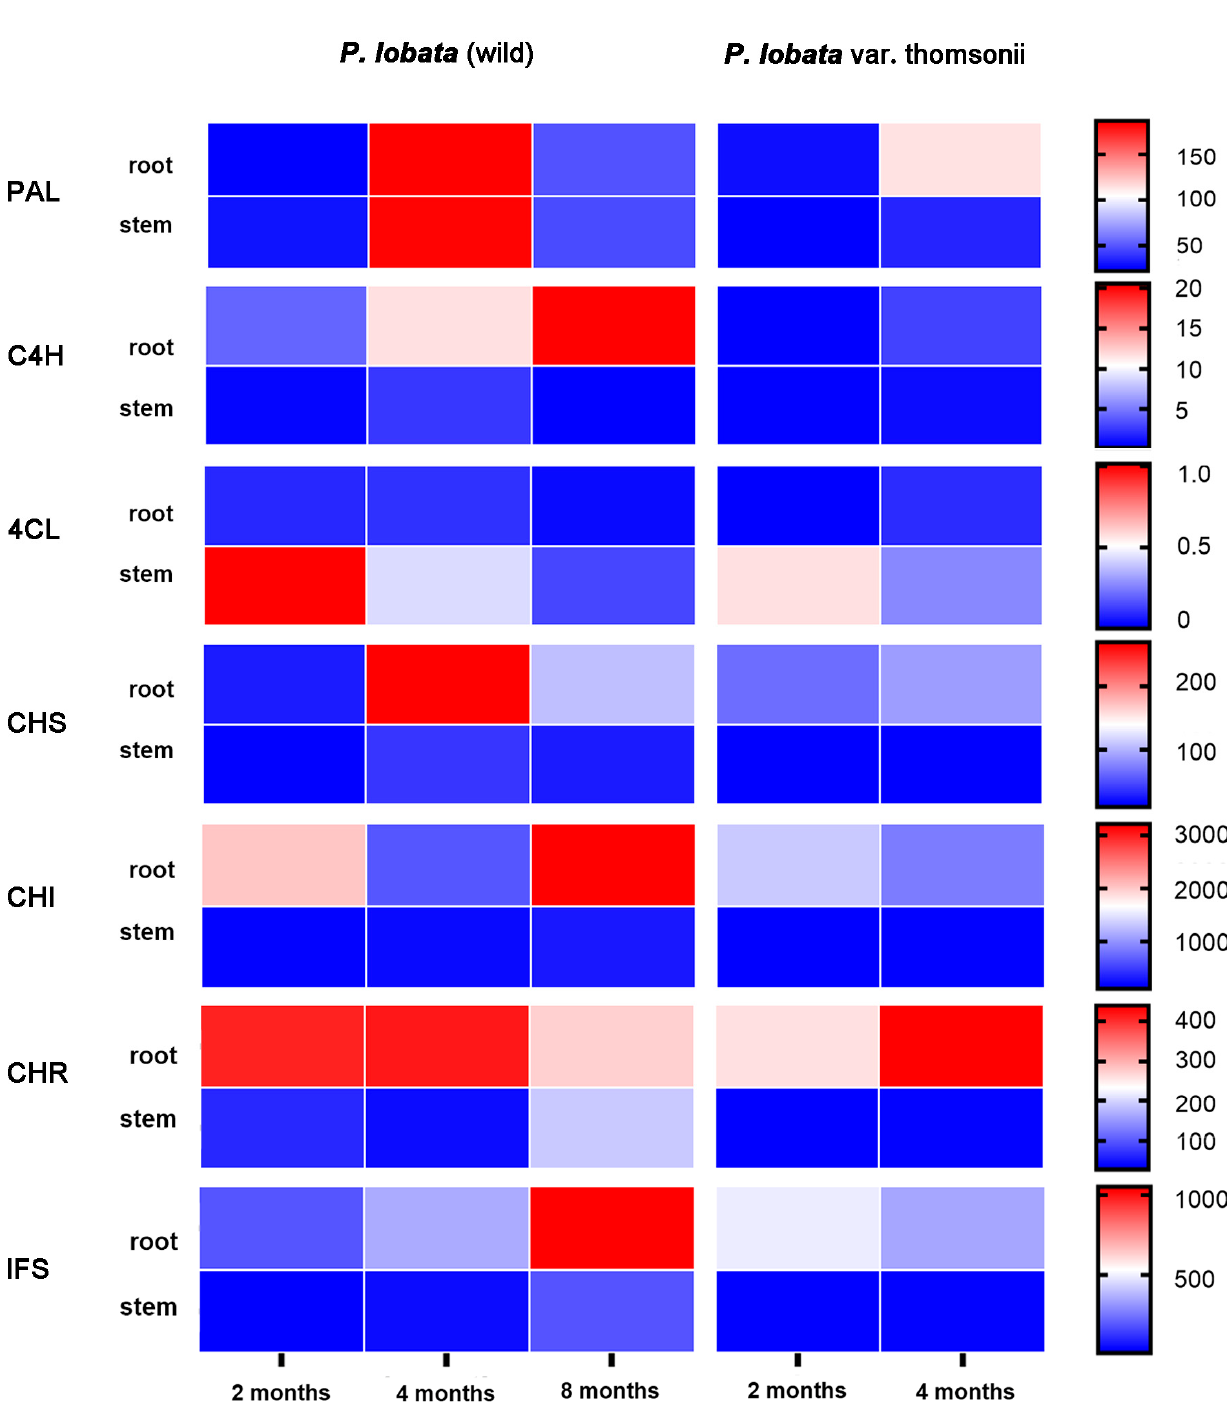
Figure 3. Heatmap representing the expression profile of the upstream isoflavone biosynthetic genes in the analyzed tissues of P. lobata (wild) and P. lobata var. thomsonii during different stages. The transcript abundances were assessed based on their FPKM values calculated from the RNA-sequencing data.